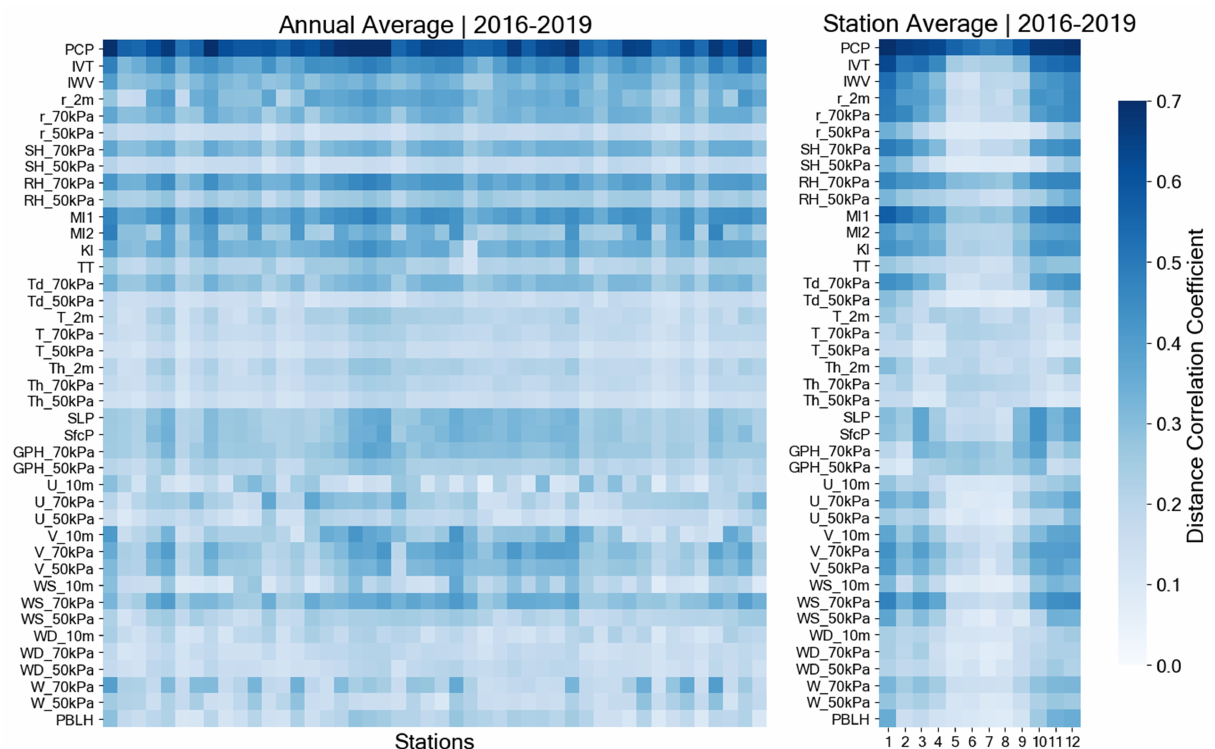
Figure A2. Distance Correlation coefficients (DCorr) of all model variables (see Table 1) with observed precipitation. Variability across 46 stations aggregated over time (left), and variability across months aggregated over stations (right). The time period covers four complete years from the optimization period (rather than the full 4.75-year period) to ensure similar sample size across